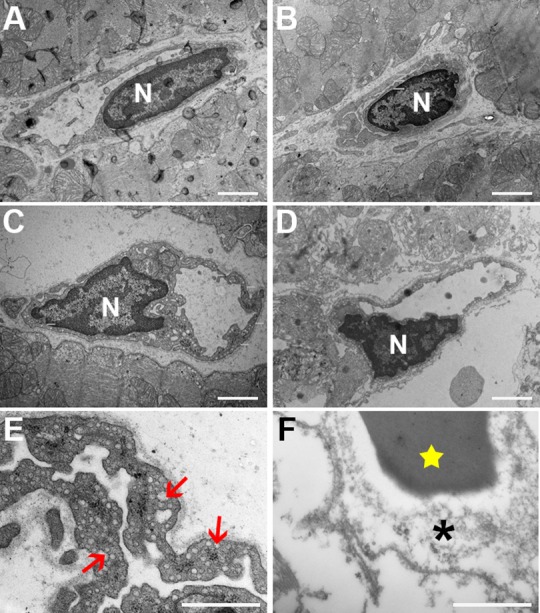
Ultrastructural images.Magnification A-D 10500x. A Capillary in the control tissue. B Capillary from infarct zone of the 30–0 group. In both A and B an intact continuous vessel wall can be seen. C Image depicts the 90–0 group and shows activated endothelium with abundant presence of caveolae and vesicles. Cytoplasm shows great variety in thickness, with multiple protrusions (white triangles). D Capillary from group 30–60 which shows severely damaged vessel wall with disruption of the basal membrane. E and F show detailed images with numerous caveolae (red arrows) and destruction of the vessel wall (asterisk). Also an erythrocyte can be seen (star). Nucleus indicated with the letter N. White bars represent 2 micrometer. Magnification E-F 24.500x.